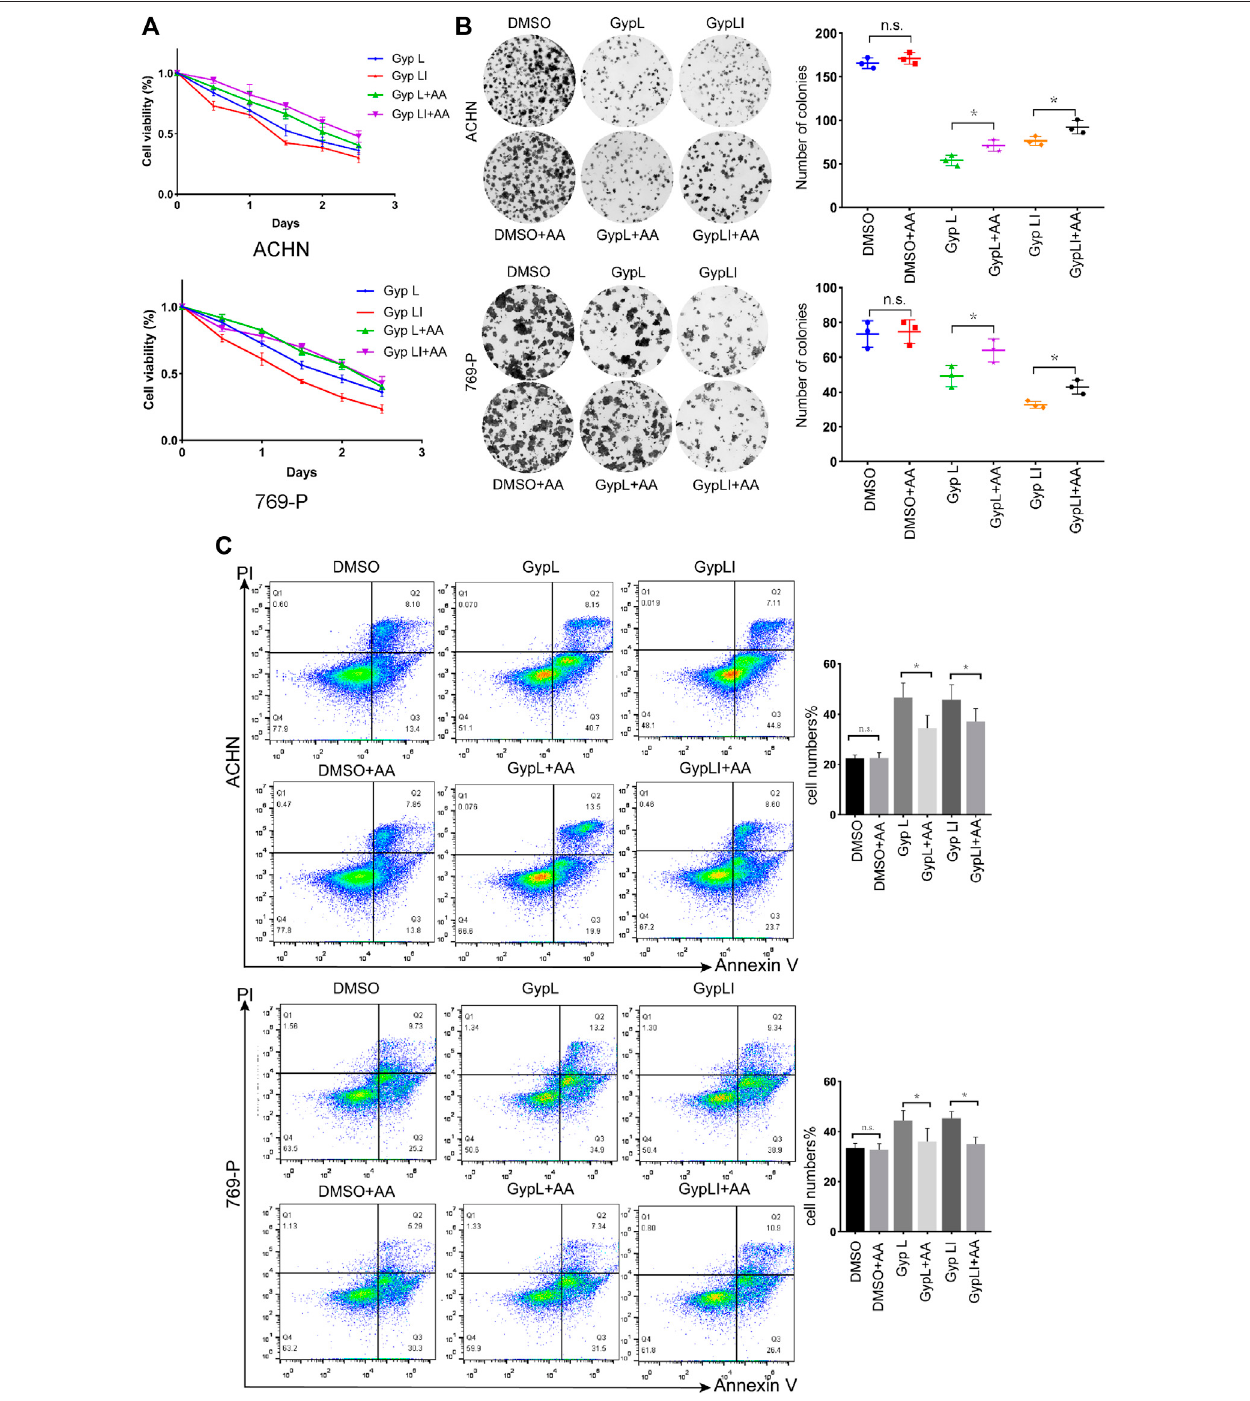
FIGURE5| ThesupplementofAArescuedthekillingeffectofGypLandLI. (A) Cellviabilityof769-PandACHNcellsfollowingtreatmentwithdifferentdosesofGyp L and Gyp LI for 48 h, supplemented with or without AA. (B) Clonogenic assays of 769-P and ACHN cells treated with different doses of Gyp L and Gyp LI under conditions, supplemented with or without AA. (C) Cell apoptosis of 769-P and ACHN after treatment with Gyp L and LI, with or without AA detected by fl ow cytometry. Data are presented as the mean ± SD of expression levels from three independent experiments (n.s., not signi fi cant; * p < 0.05, vs. control group).